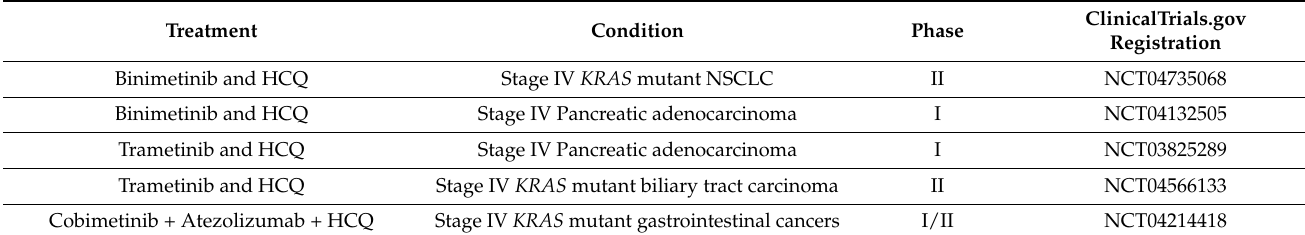
Table 2. Current clinical trials combining MAPK pathway inhibitors and autophagy. Treatment Condition Phase